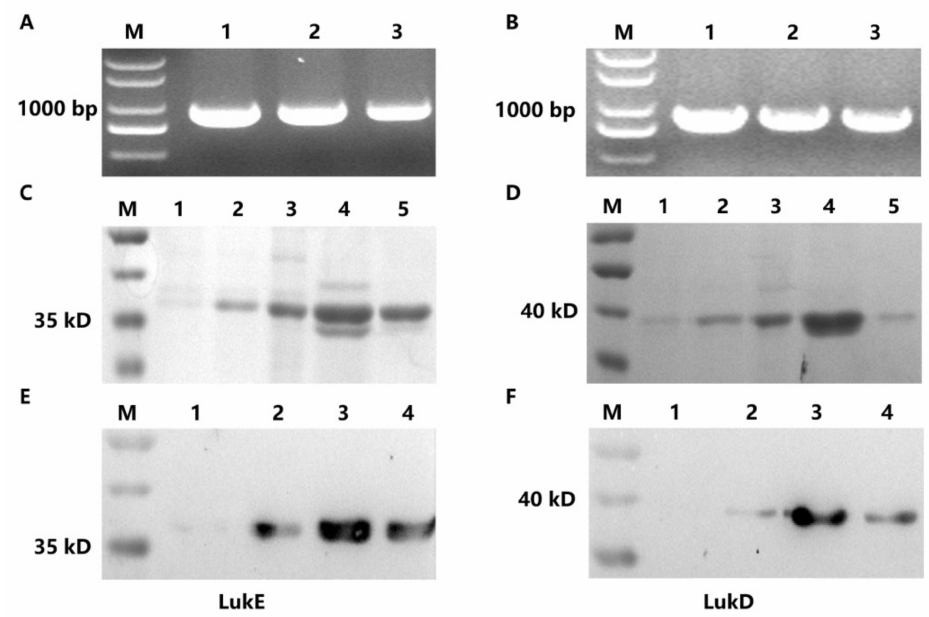
Figure 1. The gene fragments and protein products of leukotoxin ED of S. aureus . ( A , B ) PCR amplification products. Lane M of ( A , B ), 2000-bp DNA ladder; lanes 1–3 of ( A , B ), PCR amplification product of lukE ( A ), lukD (B ). ( C , D ) The SDS–PAGE analysis. Lane M of ( C , D ), protein molecular weight marker; lanes 1–5 of ( C , D ), the purified protein of LukE and LukD eluted by 20, 40, 60, 100 and 150 mM imidazole, respectively. ( E , F ) The western blotting assay. Lane M of ( E , F ), protein molecular weight marker; lane 1 of ( E , F ), without IPTG induction; lanes 2–4 of ( E , F ), the purified protein of LukE and LukD eluted by 60, 100 and 150 mM imidazole,